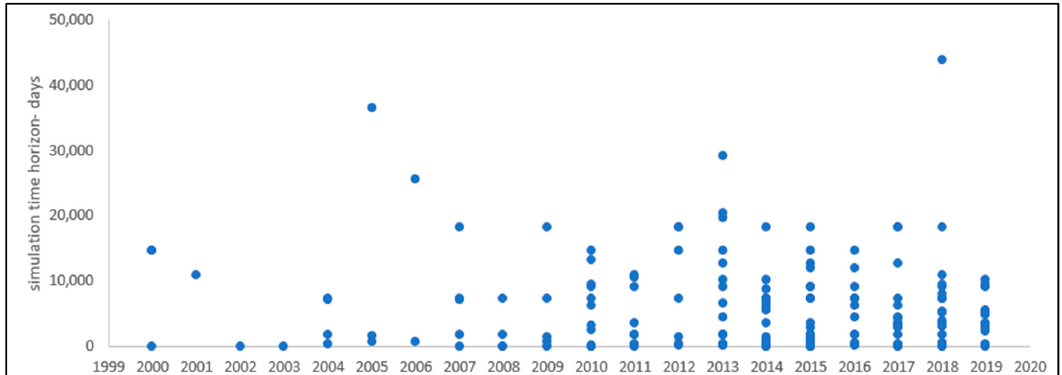
Figure 11. Time horizons among the selected papers.